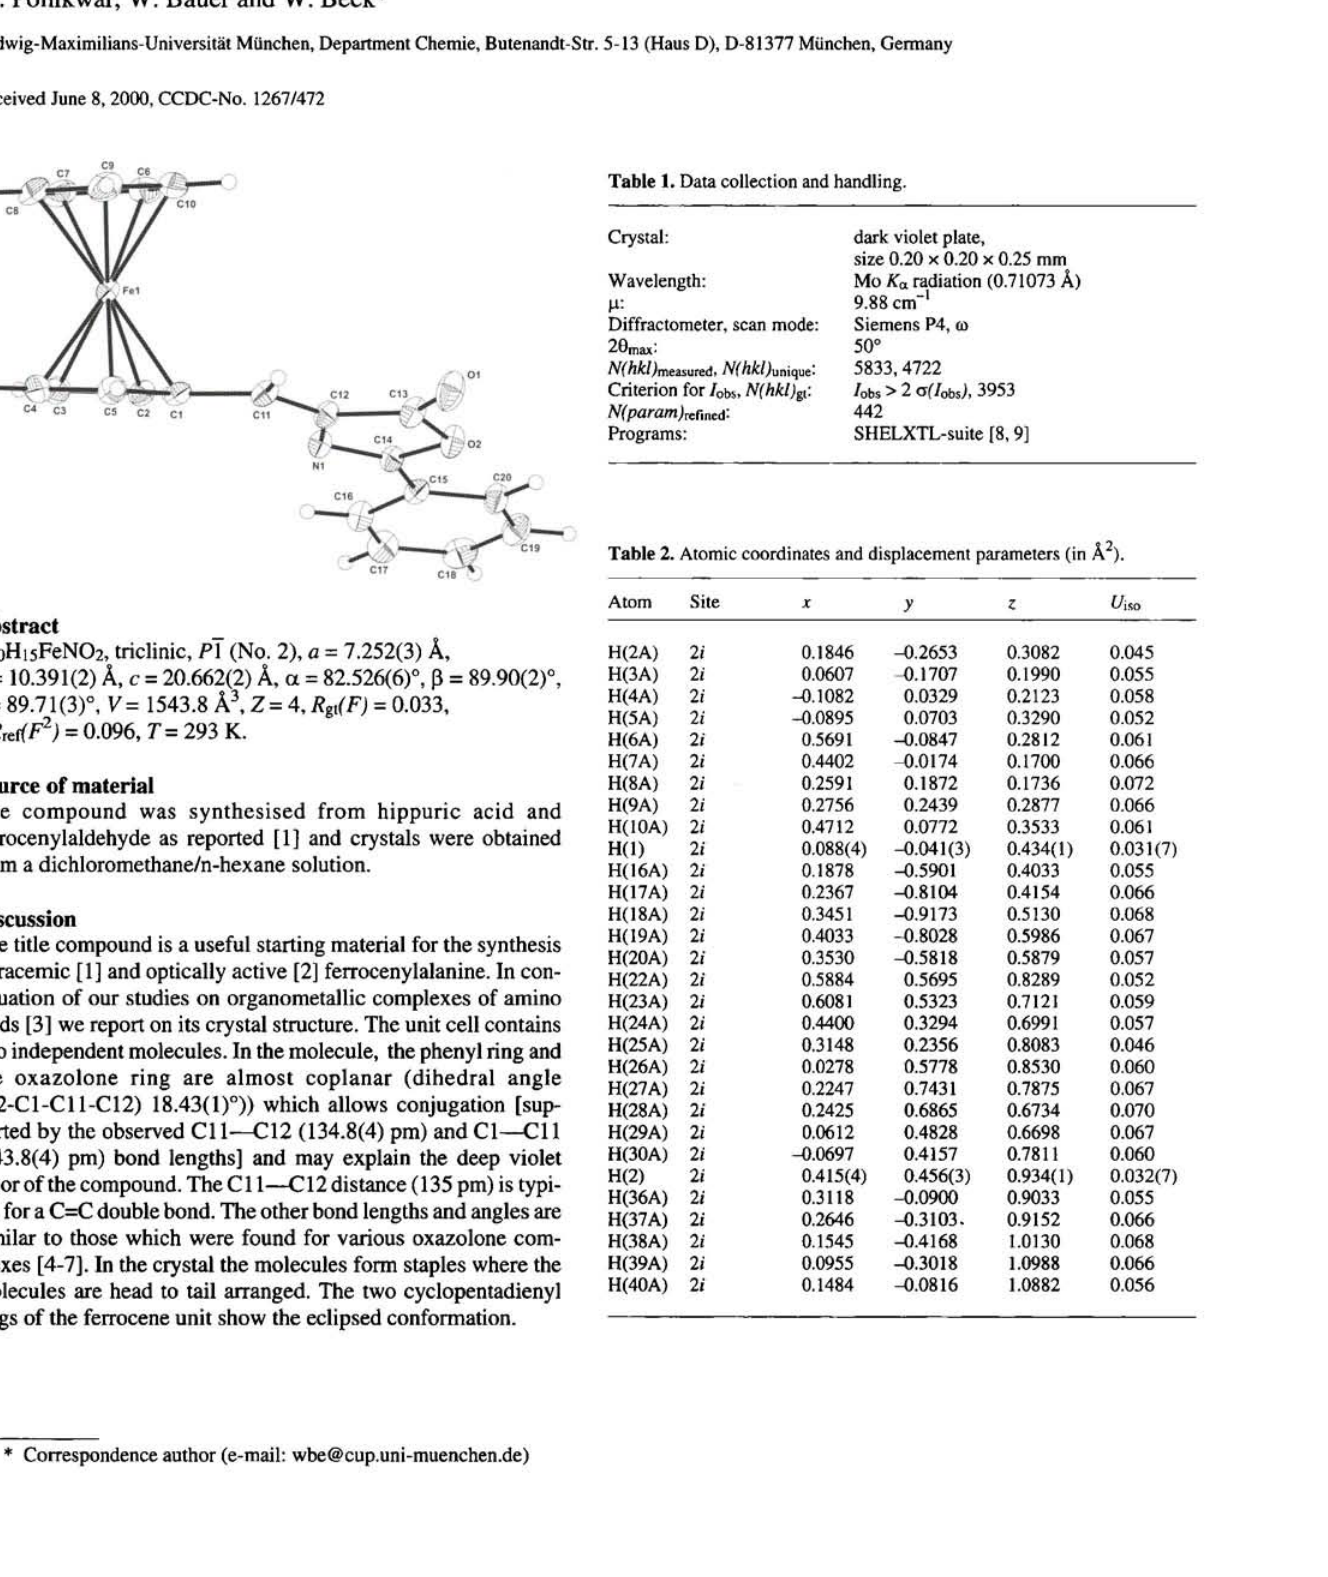
Table 1. Data collection and handling.